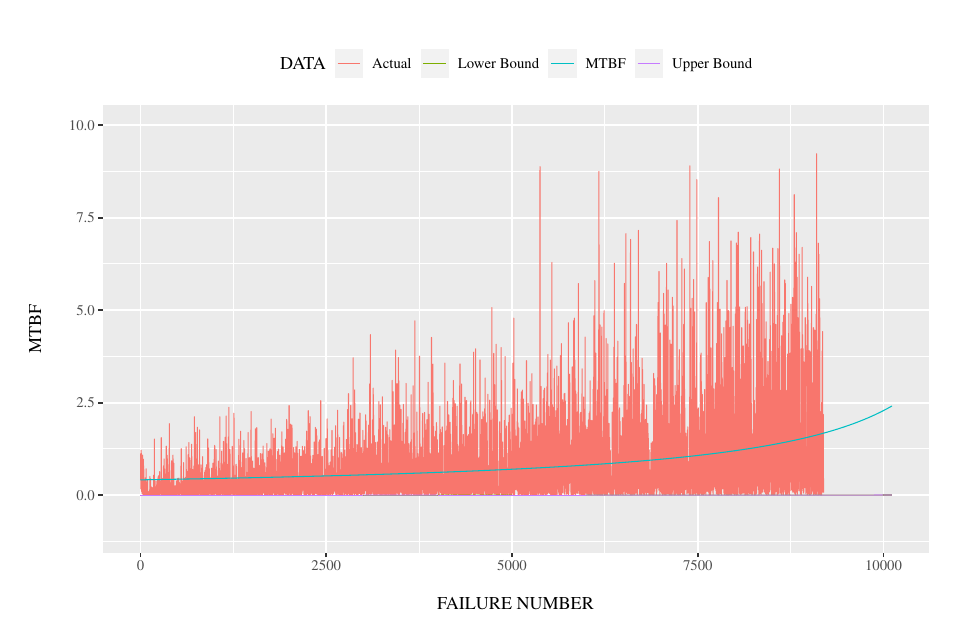
Figure 7. The estimated upper and lower confidence limits based on the conventional method.